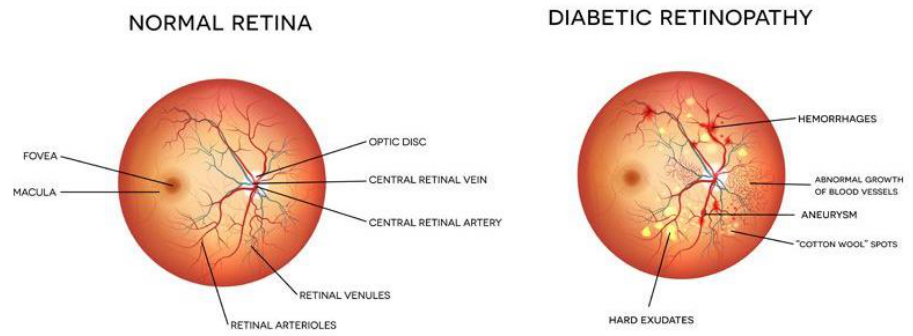
Figure 1. Eye structure and presence of DR [Image credit https://www.eyeops.com/, accessed on 20 September 2022].